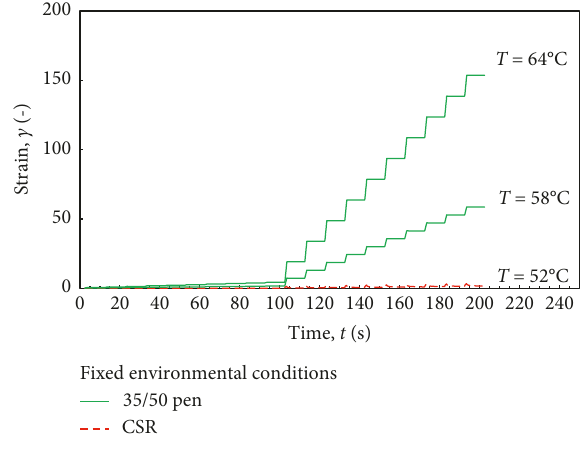
Figure 25: Hypothesis scenario ( c vs. t )—35/50 pen vs. CSR strain evolutions at different temperatures.